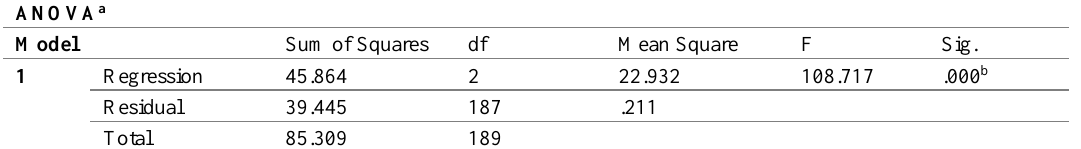
Table 9: ANOVA and